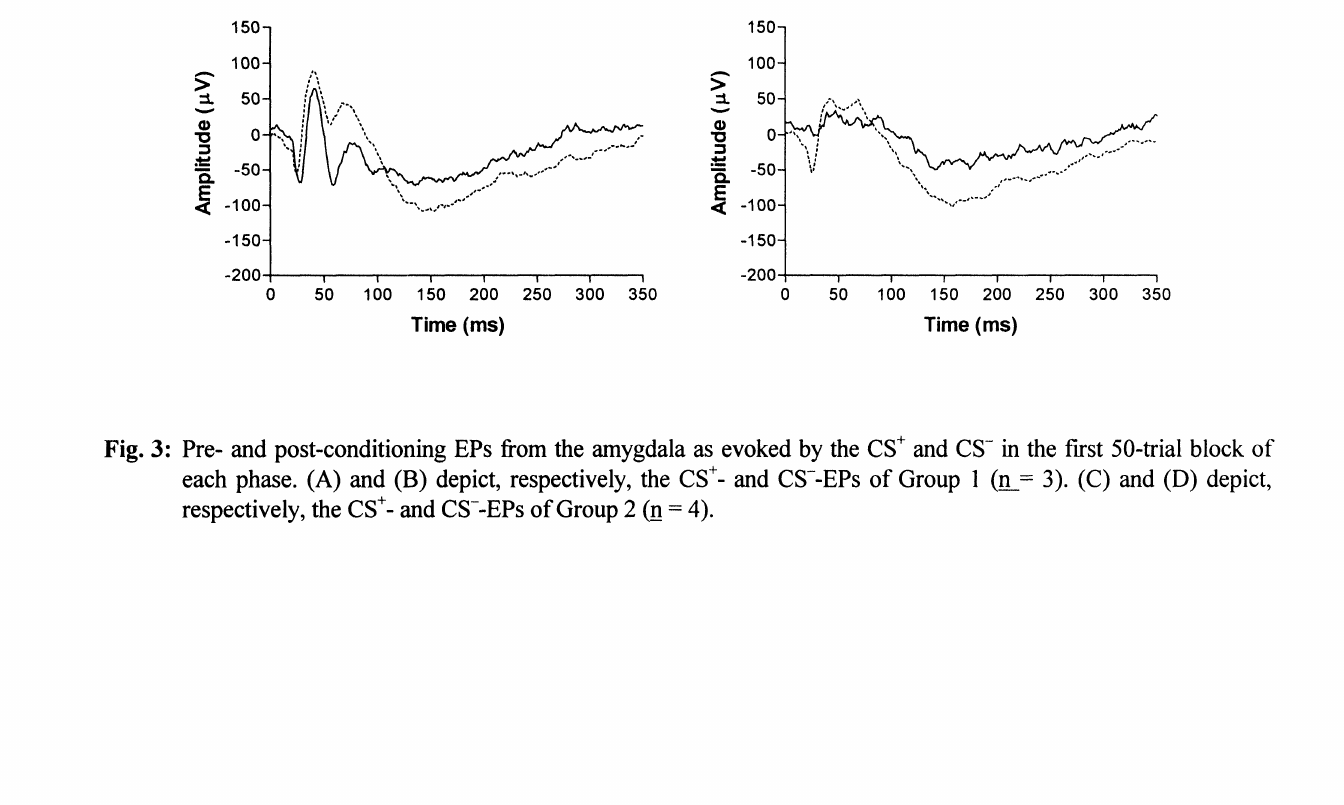
Fig. 3: Pre- and post-conditioning EPs from the amygdala as evoked by the CS + and CS- in the first 50-trial block of +- and CS--EPs of Group (n 3). (C) and (D) depict, each phase. (A) and (B) depict, respectively, the CS +- and CS--EPs of Group 2 (n respectively, the CS